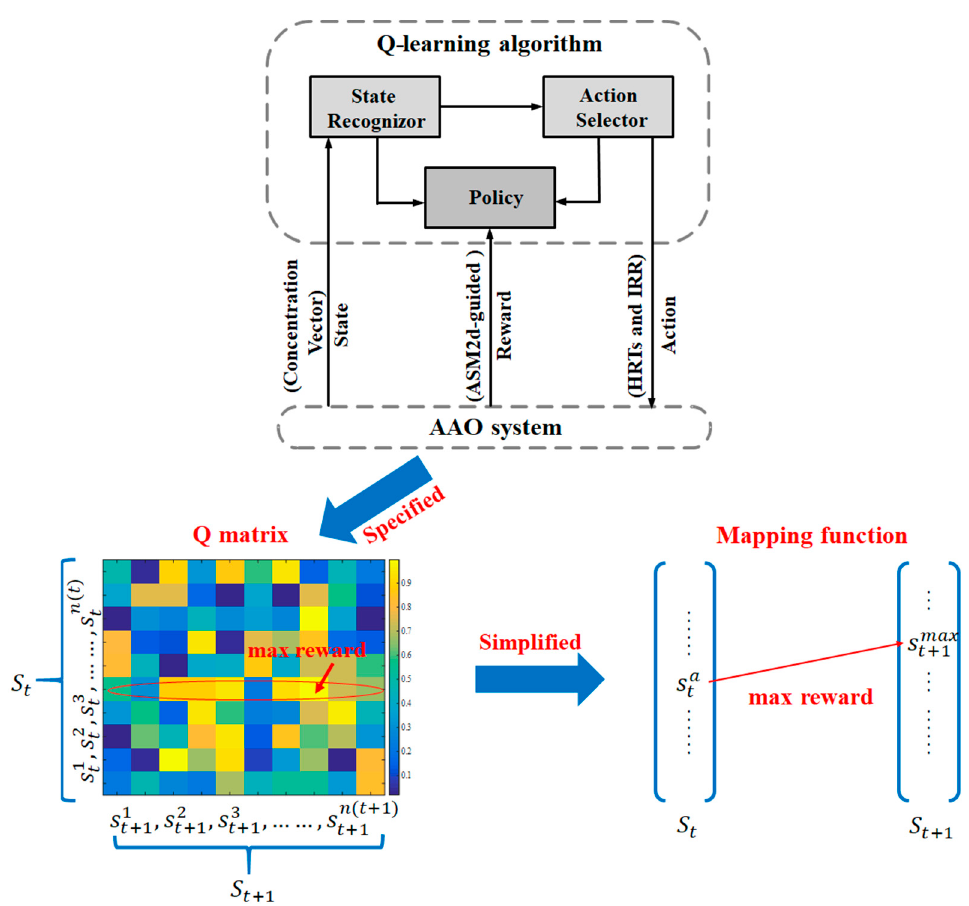
Figure 2. An example of the Q matrix and the corresponding simplified mapping function of the AAO system.